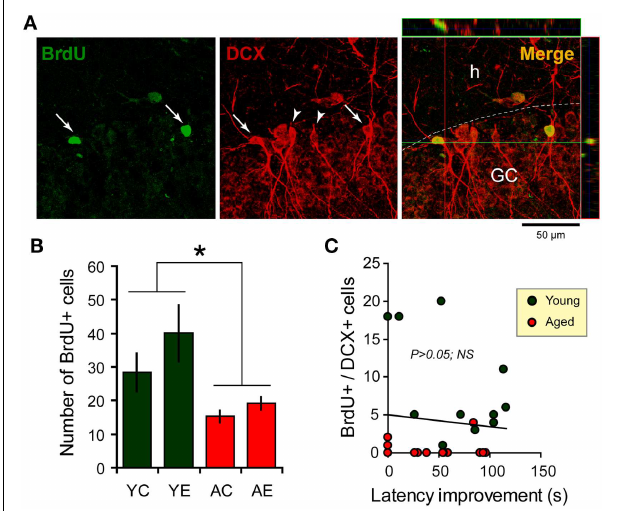
FIGURE 4 | Newborn cells in the dentate gyrus (DG) over the period of the spatial memory task as examined through bromodeoxyuridine (BrdU, green) and doublecortin (DCX, red) immunostaining . (A) Newborn cells (arrows) in the DG co-express DCX (arrowheads), a marker of immature neurons. Flaps on the top and at the left of the main photograph show images merged from orthogonal planes that run through the red and green lines of the main photograph. (B) Quantification of BrdU-positive cells in the hippocampus shows an increase in the number of new cells added over a similar period of time for young-epileptic (YE) group compared to young controls (YC) and aged animals (AC, aged control; AE, aged epileptic). * P < 0.05 comparing young to aged groups (ANOVA, followed by SNK post hoc test).Values are expressed as the mean ± SEM. (C) No correlation was found between the number of BrdU + /DCX + cells and the performance 7days after training in the water maze (latency improvement). Data from young and aged animals are represented in different colors for clarity purposes (correlation curve not shown, P >